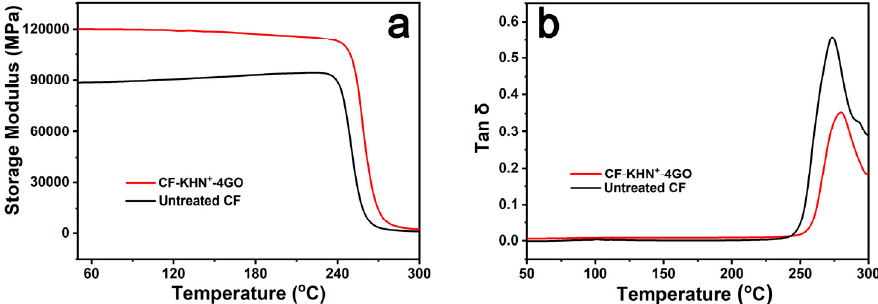
Figure 12. Temperature dependence of untreated CF/PPEK and CF/GO/PPEK composites: ( a ) stor- age modulus, and ( b ) loss tangent delta.